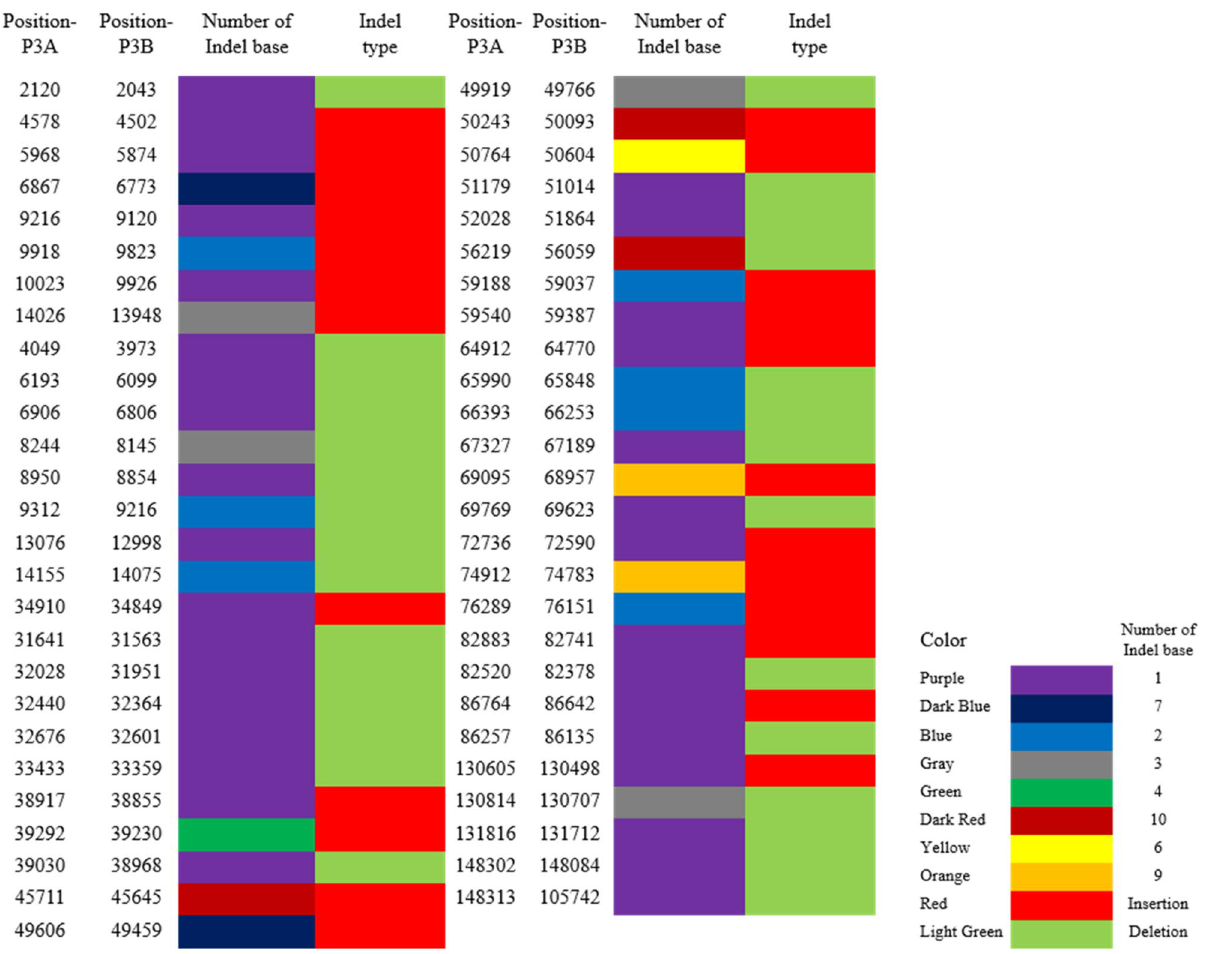
Figure 8. Indels in gene intron and intergenic regions between P3A and P3B. Excel software was used for data processing and graph